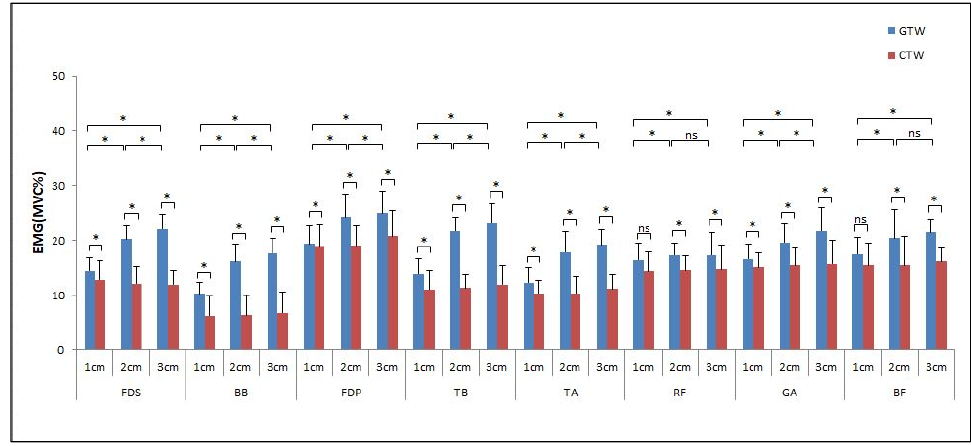
Figure 9. Upper and lower extremity muscle activity in obstacle terrain ( ns not significant, * significant difference ( p < 0.05)).